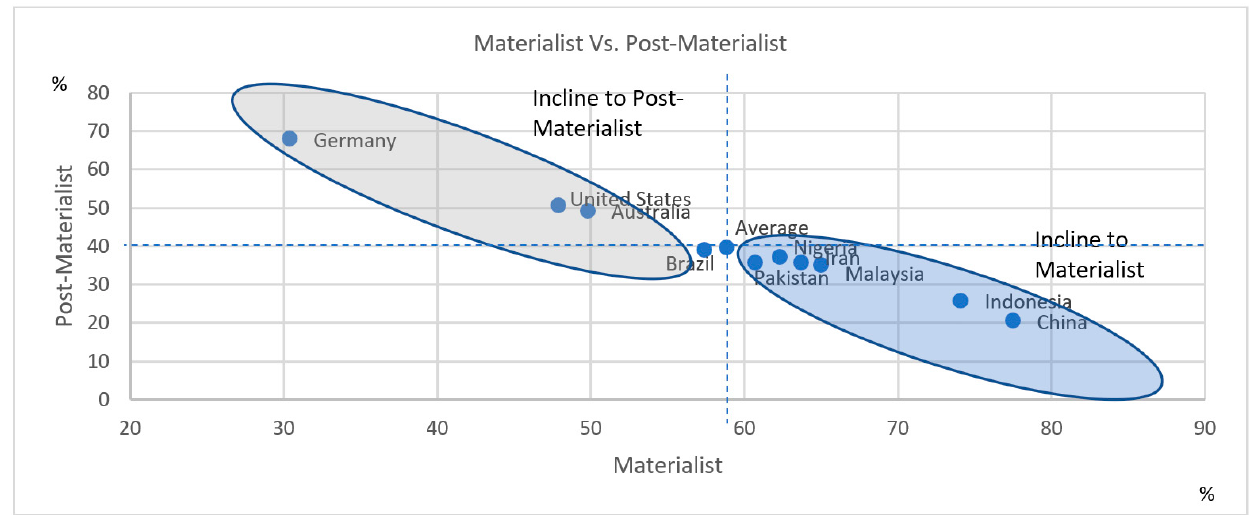
Figure 9. Materialist vs. Post-Materialist for the selected countries. Note: Following the analysis by [40,41], the Order and Economic Security are paired to represent the value of Materialist, while the Political Participation and Free Speech are paired to represent the value of Post-Materialist.